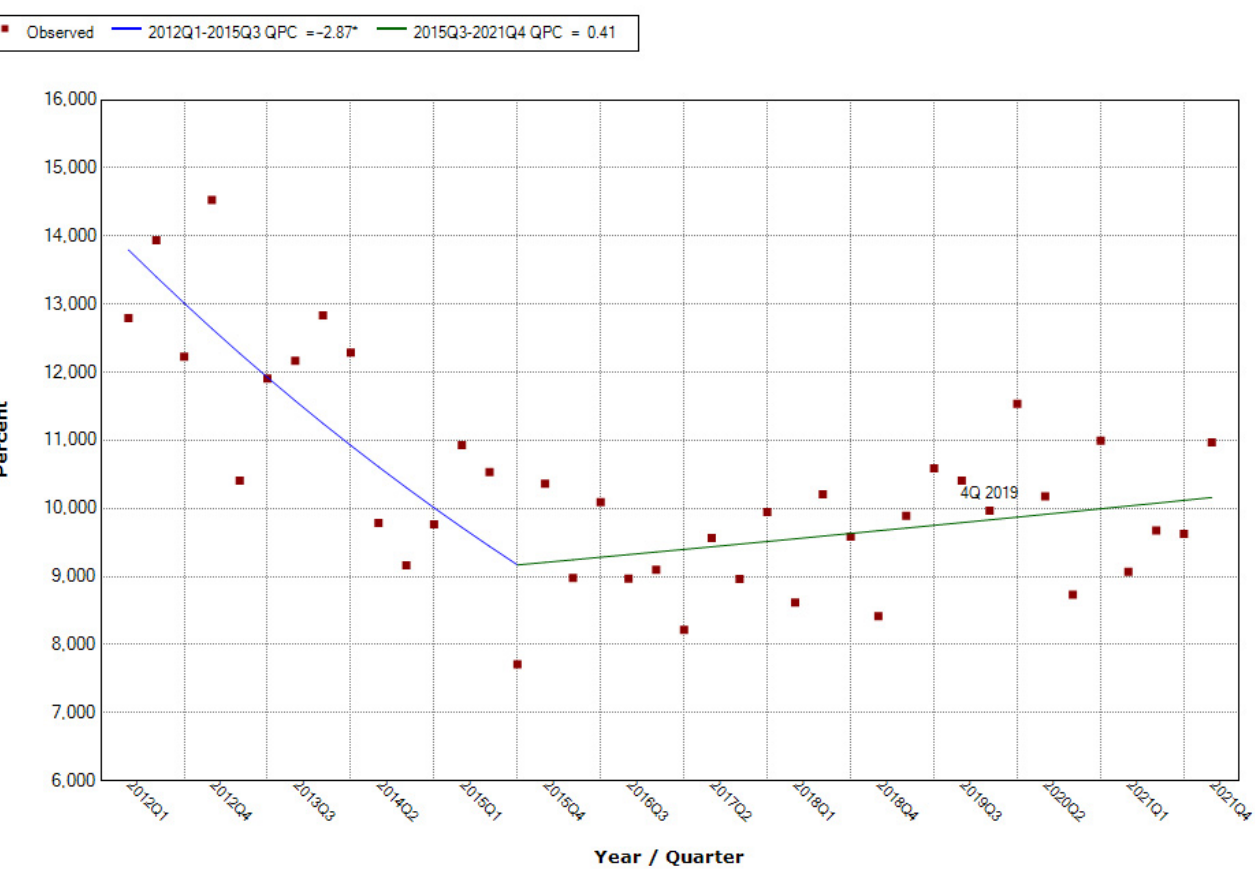
Figure A22. Percentage of products containing magnesium in individual quarters in the period from 2012 to 28 November 2021. Joinpoints mark trend turning points. The date above the observation indicates the moment of publication of the scientific opinion/resolution.